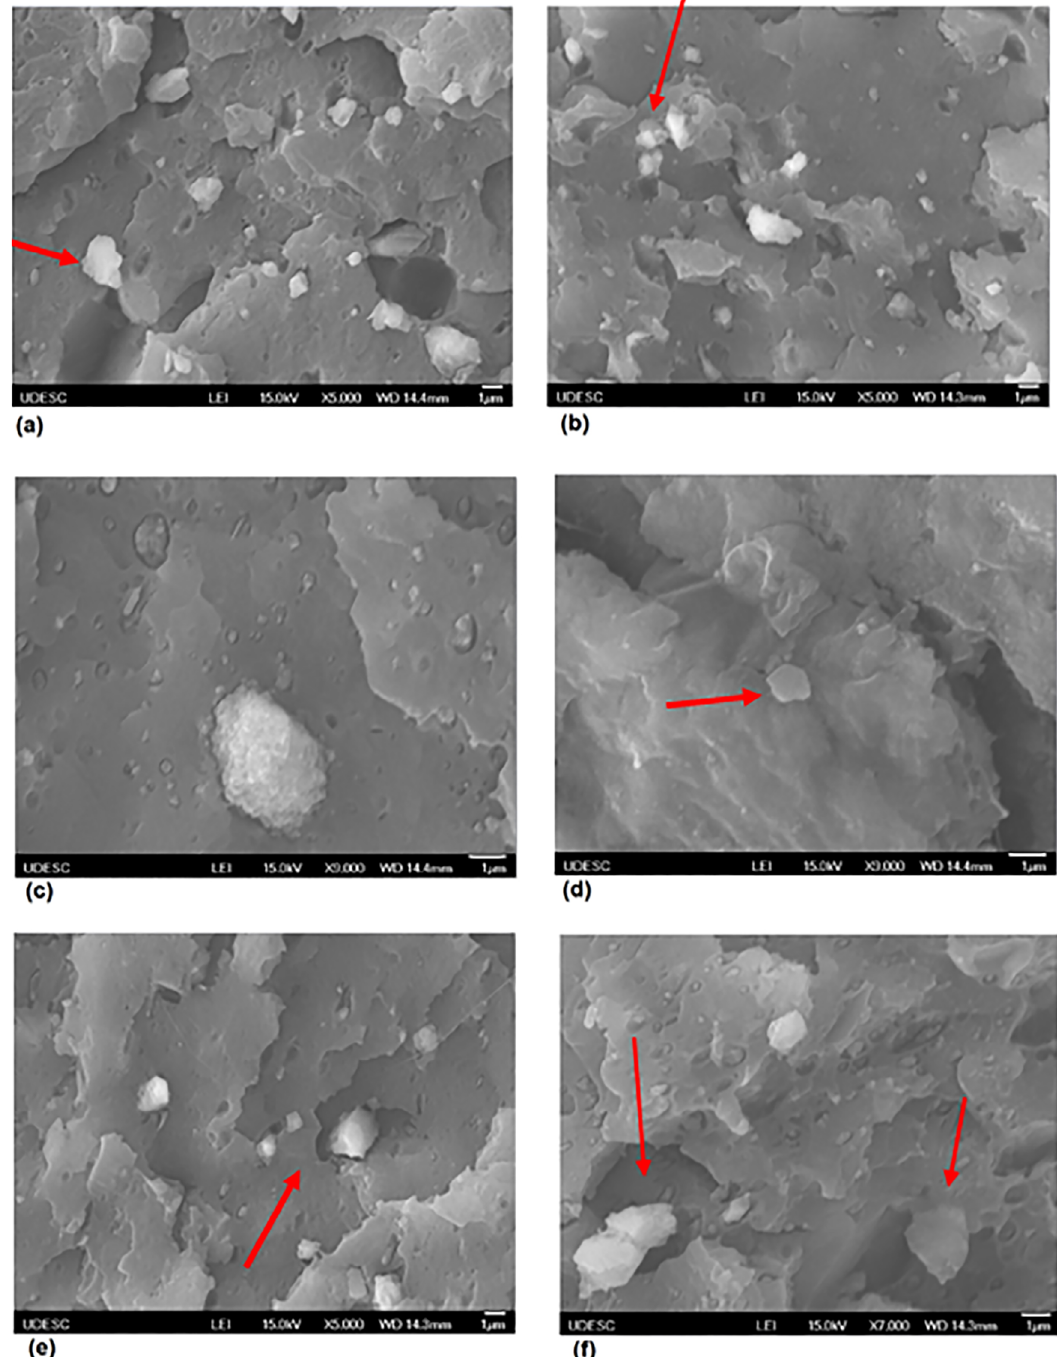
Figure 3. Micrographs of fractures of formulations obtained by SEM: a) F1-5M 5000x b) F2-10M 5000x c) F3-5N 9000x d) F4-10N 9000x e) F5-MOD 5000x and f) F6-5NM 7000x. Fig. 6 shows micrographs of the PVC with micro with good size homogeneity, but a high level of particles and nano-CaCO . The formulation F1-5M, F2-10M and agglomeration. The formulation F6-5NM has both micro and 3 F5-5MOD with darker color, show the presence of micro- nanoparticles, irregular and nanospherical. The presence of CaCO some agglomerates is consistent with the viscoelastic effect in regular shape (rhombohedric). The formulations 3 seen in the sample analyses by F3-5N e F4-10N show the nano-CaCO in spherical shape, 3